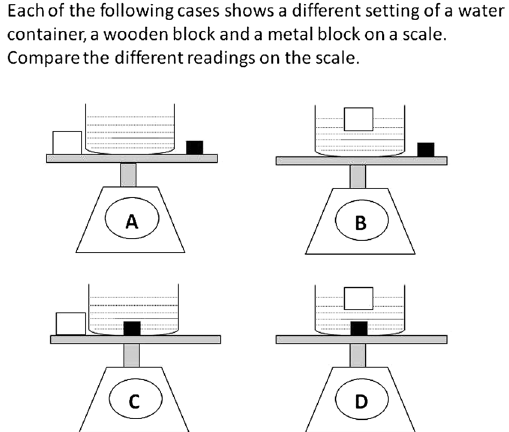
FIG. 1. The problem posed to students. Adapted from Leonard et al.